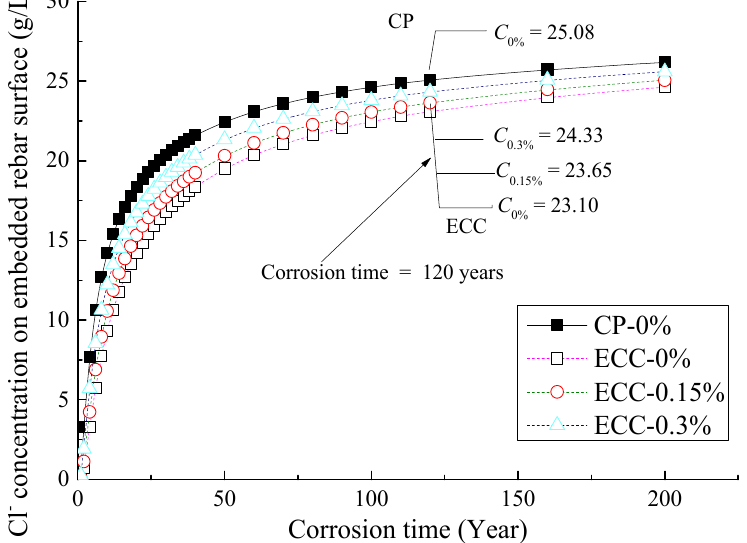
Figure 12. Predicted chloride concentration on the surface of rebars based on Fick’s second